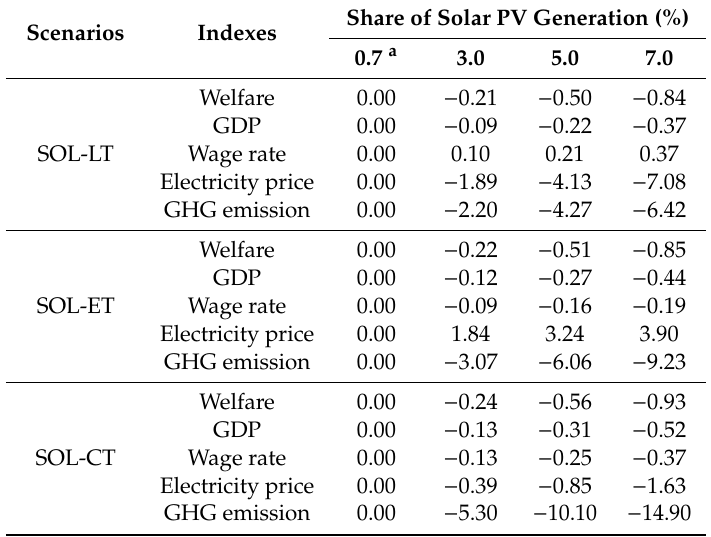
Table 6. Macroeconomic E ff ects of solar PV generation expansion (% changes from the base year). Share of Solar PV Generation (%) Scenarios Indexes 0.7